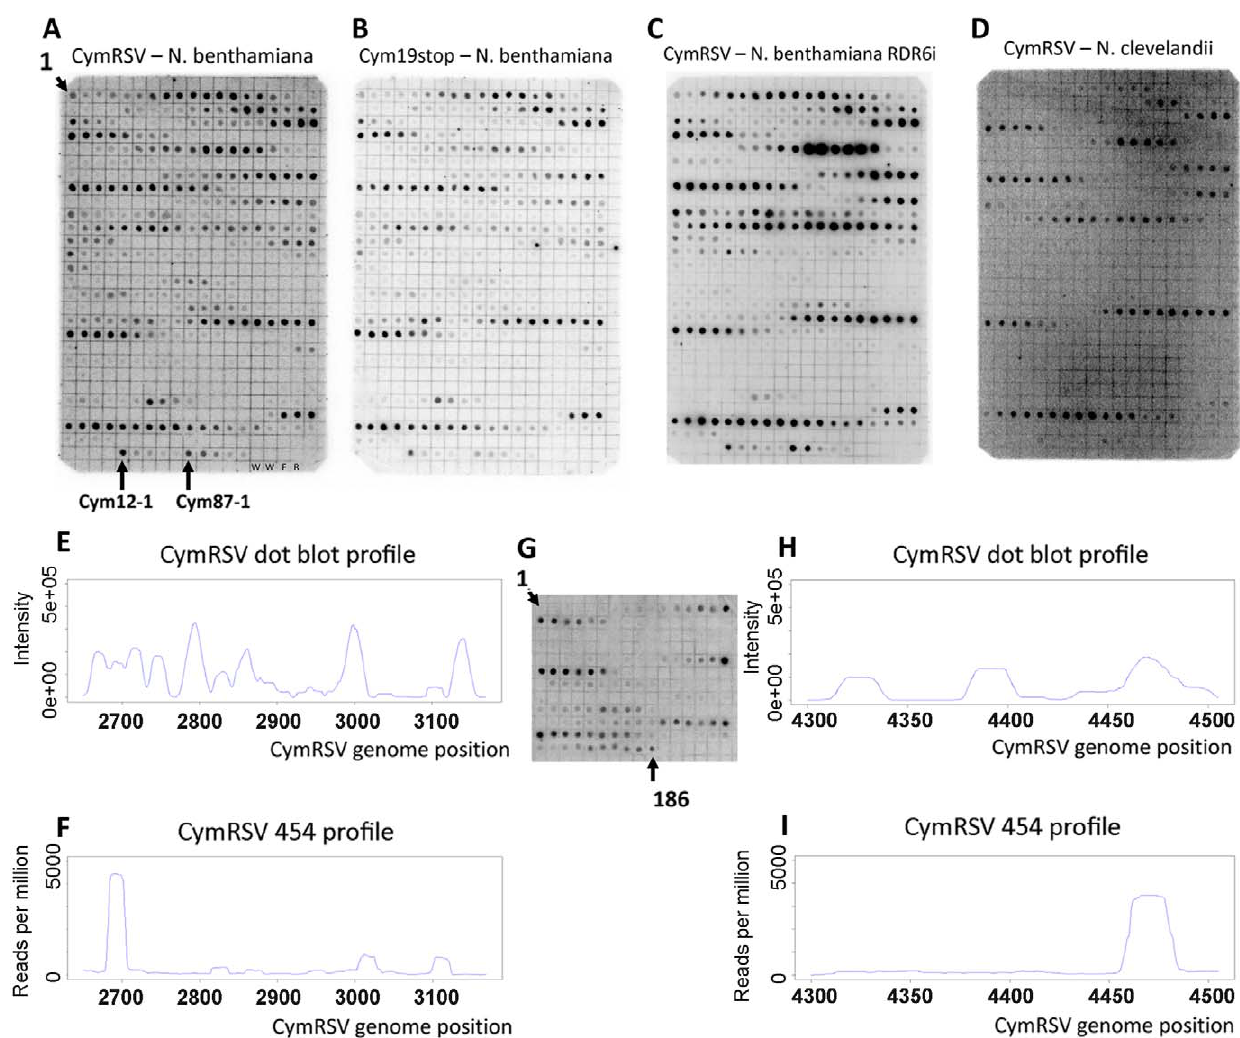
Figure 1. Dot blot and 454 profile of vsiRNAs. Short RNA fraction was purified from in vitro transcribed virus infected plants, dephosphorylated, 5 9 labelled and hybridised to membranes containing 21mer oligonucleotides in a one nucleotide sliding window complementary to the plus strand of CymRSV in positions 2650–3169 (A–D) or 4300–4505 (G). Tissues of wild type N. benthamiana infected with either wild type CymRSV (A and G) or with p19 deficient mutant CymRSV (B) and either transgenic N. benthamiana with reduced RDR6 expression (C) or wild type N. clevelandii (D) infected with wild type CymRSV were used for RNA extraction. Signal intensity of dots on panel A was quantified and plotted along the viral genome (E) and compared with the read frequency for the same region obtained through 454 sequencing (F). Signal intensity of dots on panel G was quantified and plotted along the viral genome (H) and compared with the read frequency for the same region obtained through 454 sequencing (I). The layout of the membranes in panel A–D is the same since the same membrane was used after stripping. The position of the most 5 9 oligonucleotides is indicated as 1 at the top left corner. The membranes contain two kinds of negative controls: two dots contain only water (W) and two non-specific oligonucleotides are M13 forward (F) and reverse (R). We monitored the specificity of hybridisation by dotting shorter oligonucleotides: an abundant probe (Cym12) was shortened from the 5 9 end by 1, 2, 3, 4 and 5 nucleotides (Cym12-1 indicates the 20mer probe followed by the shorter probes). The same approach is used for another abundant probe